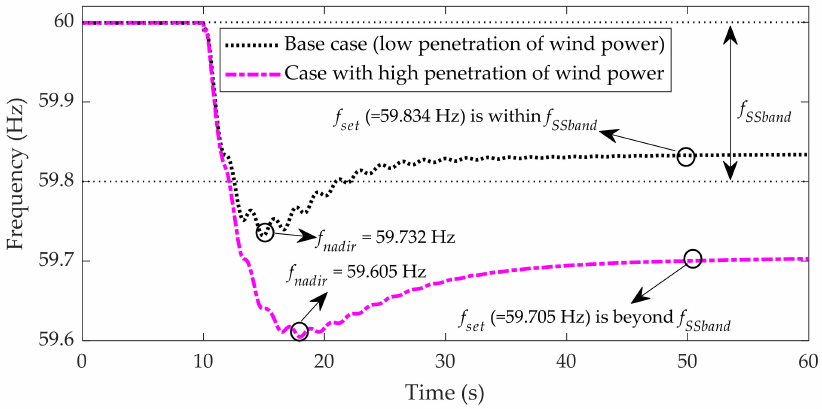
Figure 7. Effect of wind power penetration on system frequency in Korean electric power